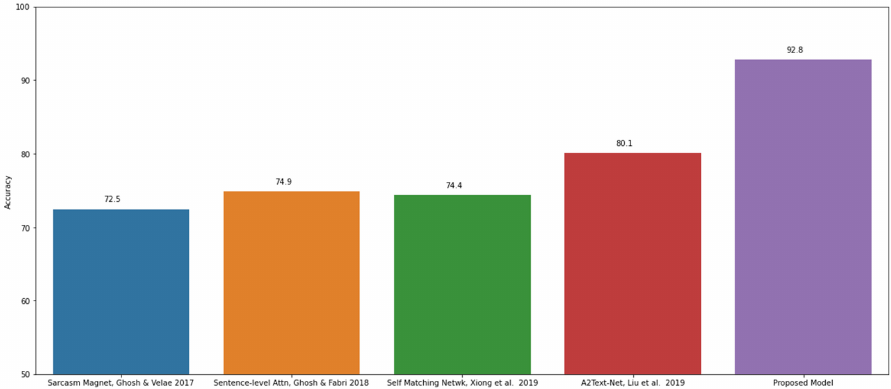
Figure 12. Confusion matrix for Twitter dataset.